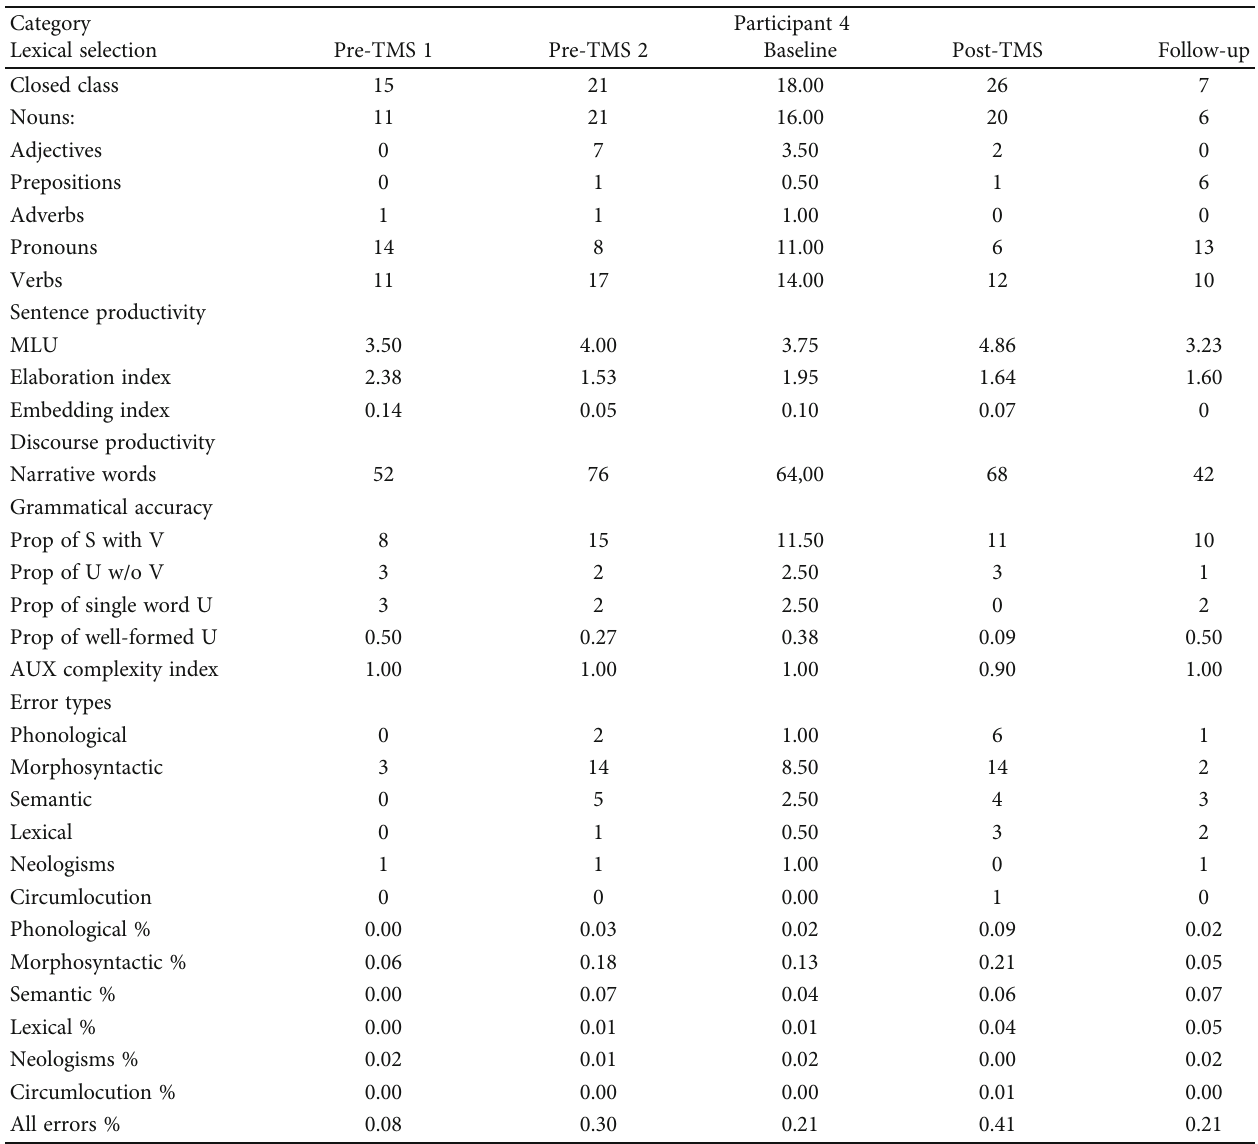
Table 6: Short-term (one day posttreatment) and long-term (two months posttreatment) e ff ects of 1Hz rTMS on narration outcomes (i.e., functional communication) for participant